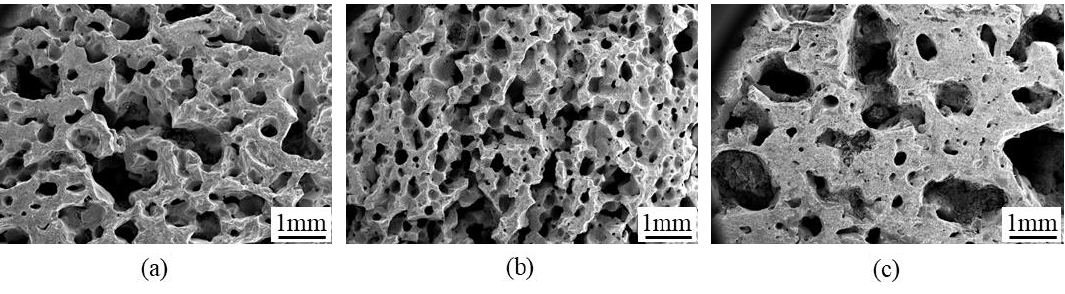
Figure 6. SEM images of SiC porous ceramics prepared at different foaming temperatures with 7.5 7.5 wt.% H 2 O 2 addition: ( a ) 75 ◦ C; ( b ) 85 ◦ C; ( c ) 95 ◦ C. Table 2. Effects of foaming temperature on the properties of SiC porous ceramics with 7.5 wt.% H 2 O 2 addition.